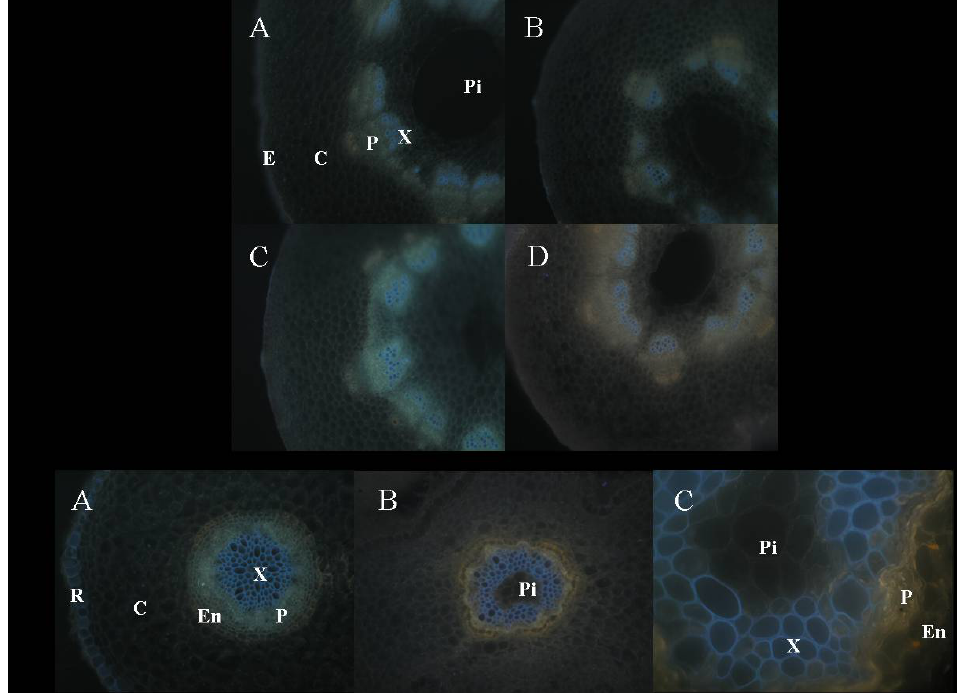
Figure 5. Sunflower shoot. Transverse stem section of sunflower cultivated without ( A ) and treated with silver(I) ions – 0.1 mM ( B ), 0.5 mM ( C ) and 1.0 mM ( D ) at fourth day of the treatment. Blue fluorescence – lignified cell walls. E – epidermis, C – cortex, P – phloem, X – xylem, Pi – pith. Sunflower root. Transverse root section of sunflower cultivated without ( A ) and treated with silver(I) ions – 0.1 mM ( B ), with detail ( C ) at fourth day of the treatment. Magnification ×